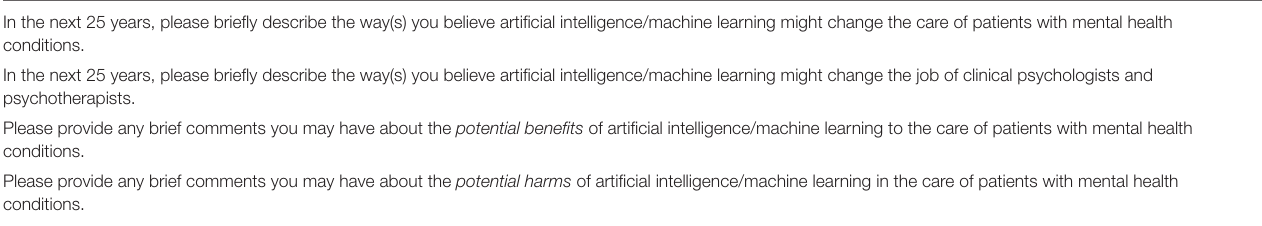
TABLE 1 | Open-ended questions.